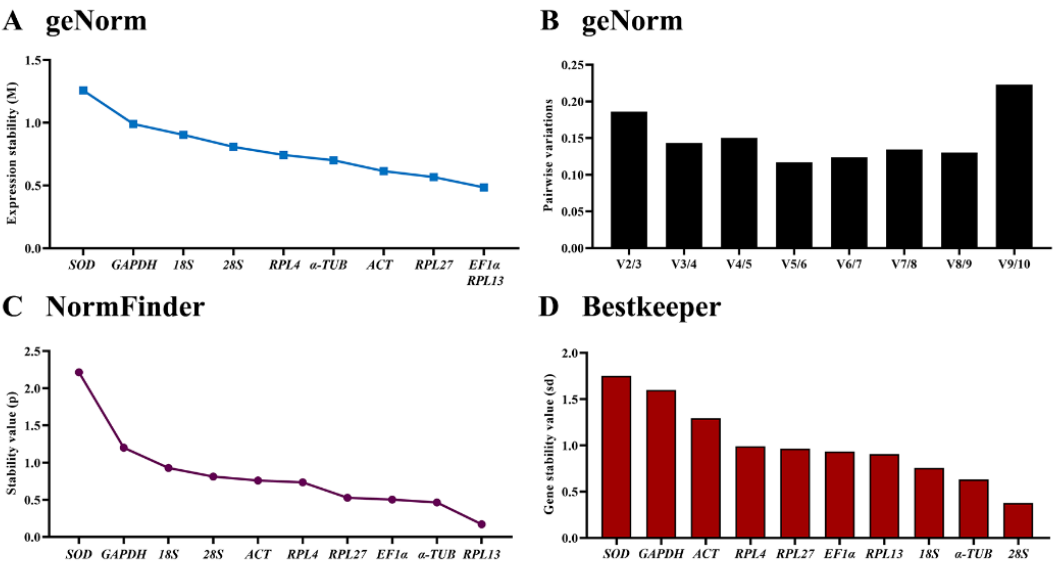
Figure 4. Expression stability of ten house-keeping genes under different temperatures in Phthori- maea operculella . The fourth-instar larvae reared under three temperatures (4 °C, 26 °C and 35 °C) were collected. The expression stability rankings were determined by geNorm, NormFinder and BestKeeper.